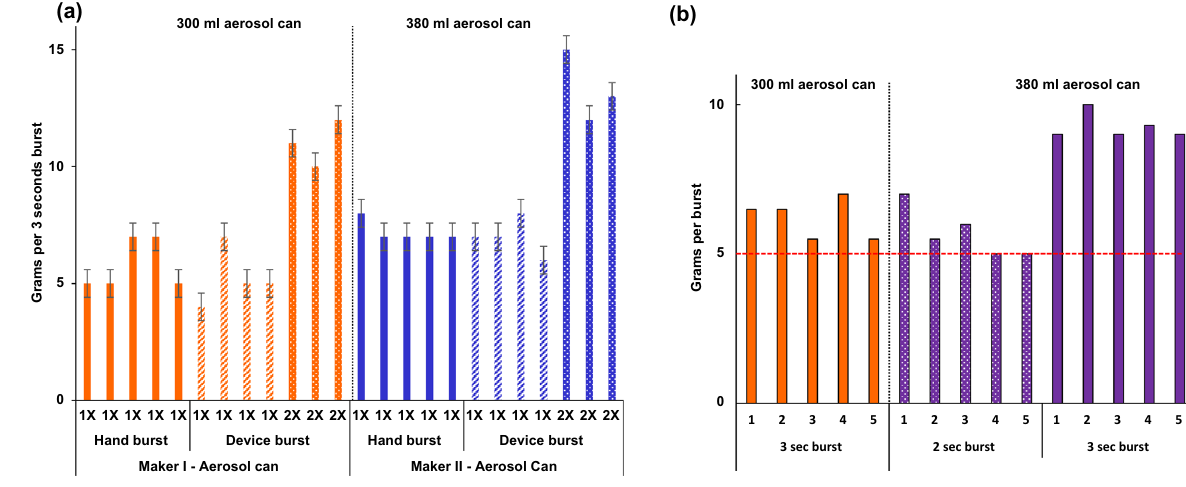
Figure 2. Validation and calibration of the remote-controlled aerosol dispenser (RCAD). ( a ) Comparison of spraying reproducibility within and between manual and automatic burst deployment. ( b ) RCAD burst length calibration to normalise spraying density across aerosol cans. The red dashed line is a baseline concentration to calibrate spraying burst length across variable spray can